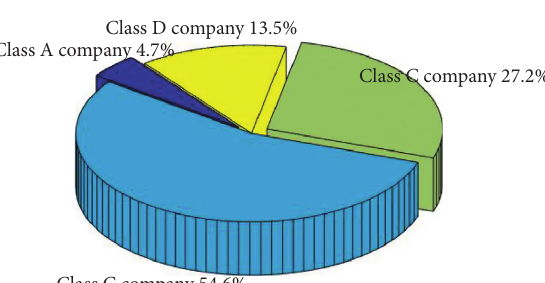
Figure 4: Visual pie chart of business classification with no loan